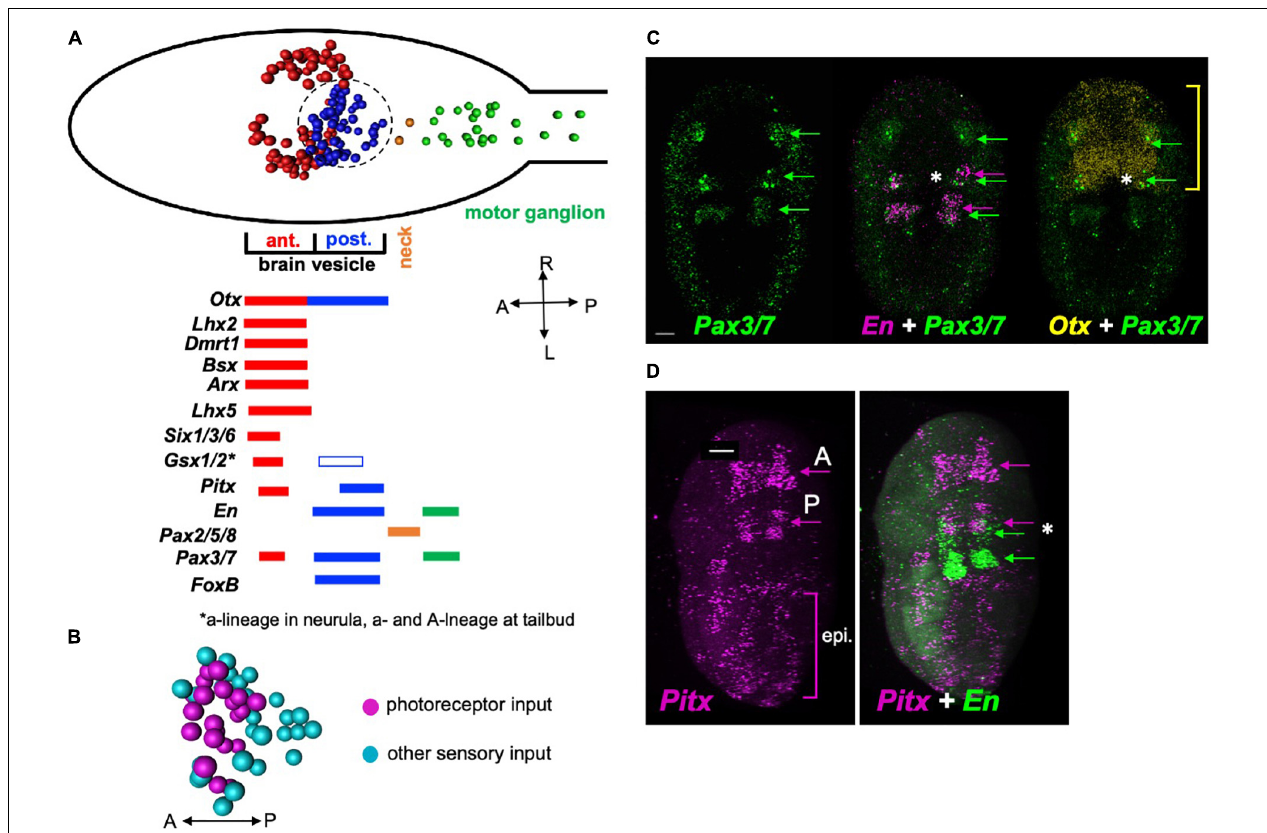
FIGURE 5 | Gene expression in the Ciona posterior brain vesicle suggests homology with the vertebrate midbrain. (A) Top: Diagram of the Ciona larval CNS with the major brain regions indicated in color. The centroids of neurons are shown (from Ryan et al., 2016). Bottom: summary of embryonic gene expression patterns marked by corresponding larval CNS domains. Domains in red show expression for orthologs to vertebrate forebrain markers, blue to midbrain, orange to MHB, and green to spinal cord. (B) Spatial distribution of relay neuron types in the pBV. Region shown corresponds to the circled area in panel (A) (centroids shown). (C) In situ hybridization for Pax3/7 , En , and Otx in early tailbud Ciona embryos. The anterior domain of En , which marks the presumptive pBV, overlaps with Pax3/7 (asterisk middle panel), and En (asterisk right panel). Yellow bracket shows anterior-posterior extent of Otx expression. (D) In situ hybridization for Pitx and En . Pitx is expressed in anterior and posterior domains in early tailbud embryos. The posterior domain of Pitx overlaps with the anterior En domain in the pBV (asterisk right panel). Consistent with previous reports, labeling was also observed in the epidermis. Green arrows in panels (C) are indicating domains of Pax3/7 expression in the developing central nervous system. In panel (D) , green arrows indicate domains of engrailed expression, and magenta arrows indicate domains of Pitx expression the central nervous system. Asterisk indicates overlapping expression of Pitx and engrailed . A, anterior; P, posterior; epi, epidermis. Anterior is to the left for panel A and D, and to the top for B and C. Scale bars are 10 µ